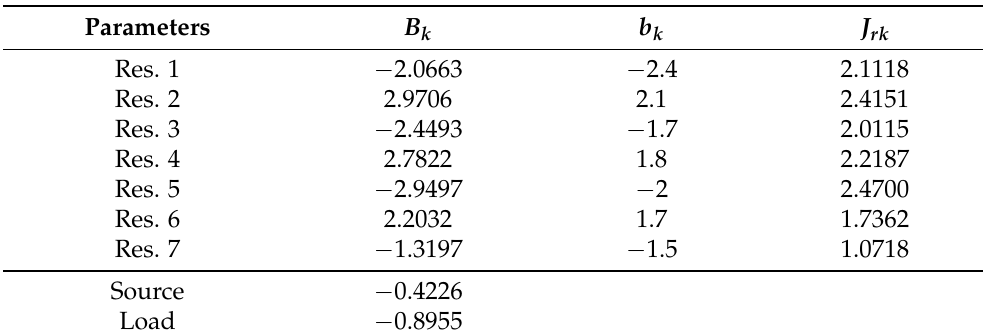
Table 6. Lowpass elements of the synthesized 7th-order ladder filter with Ω tz TZs distribution and RL = 18 dB when ψ = φ = 0 ◦ .